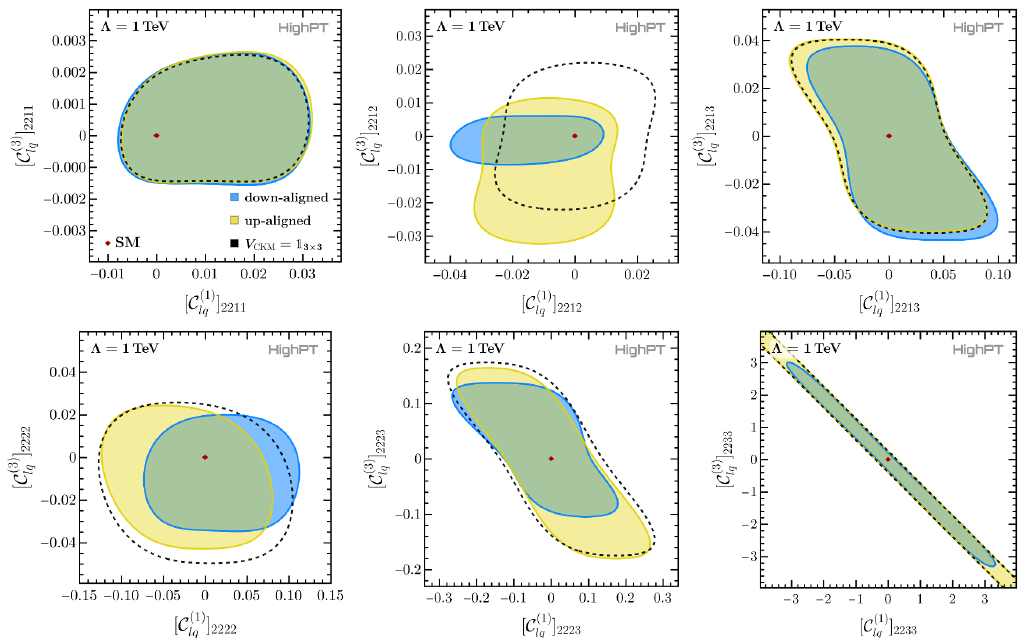
Figure 8. Two-parameter fit of the Wilson coefficients [ C (1) flavor indices. We show the 95% confidence regions for these coefficients assuming V dashed line), a non-diagonal V with up alignment (yellow region). Both dimuon and monomuon searches are considered for the constraints presented here. The coefficients are normalized by choosing Λ = 1 TeV